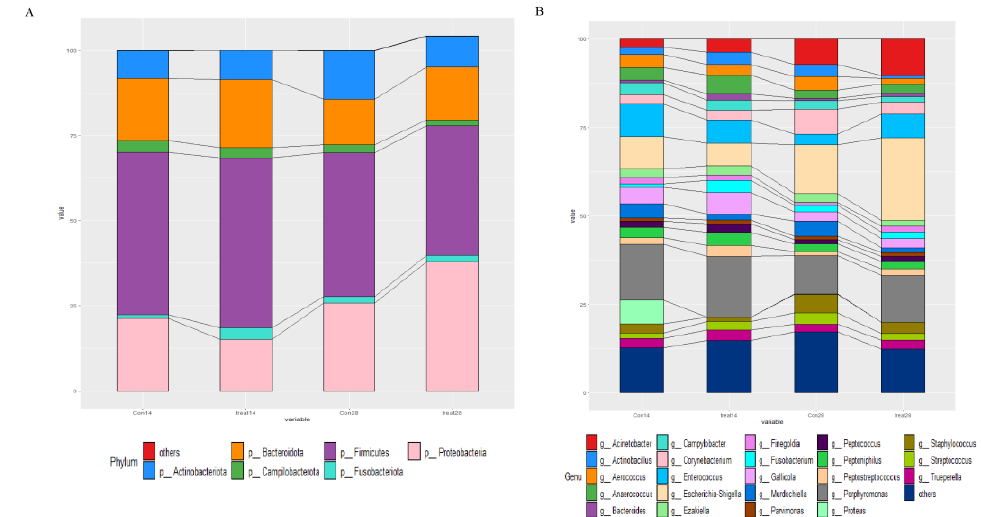
Figure 7. Effects of MSFAs during gestation on vaginal microbiota composition of sows. The relative abundances of different phyla ( A ) and genera ( B ) in the vaginal microbiota of control and treatment group sows at day 14 and day 28 at gestation.